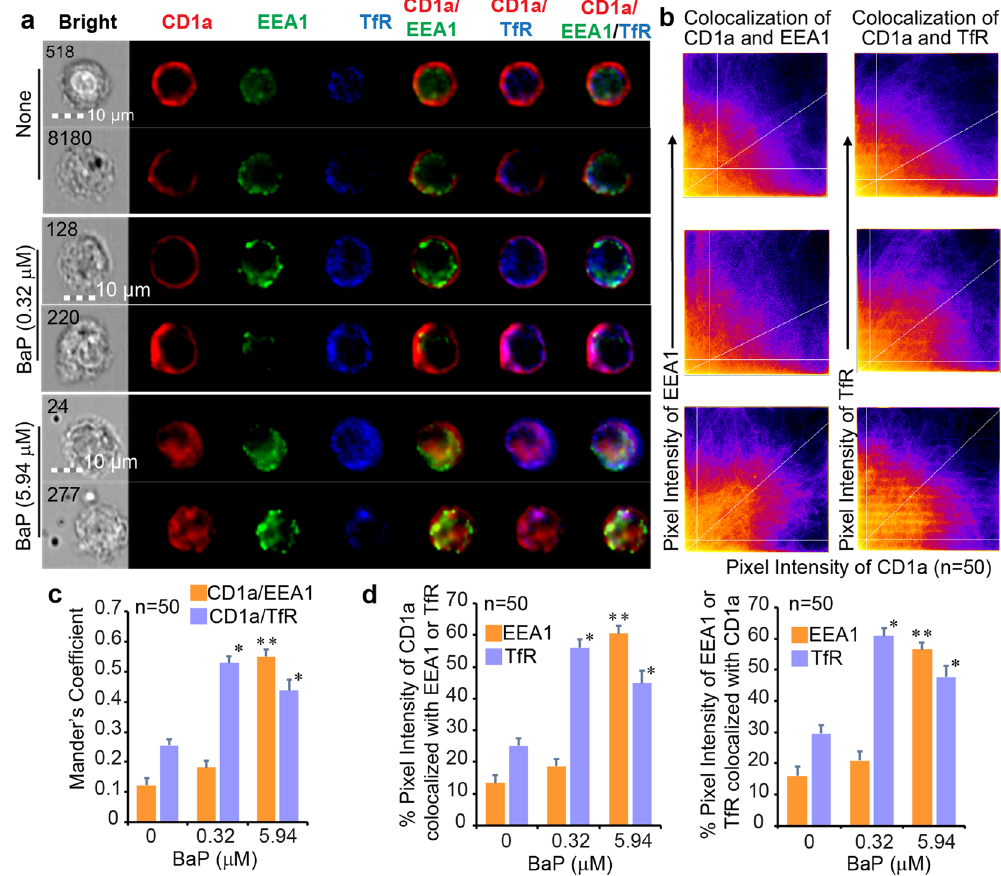
Figure 5. The CD1a protein retained in early and recycling endosomes. According to the gating strategy in Supplemental Fig. 5, two cellular images in the gated HLA-DR + CD11c + CD1a + EEA1 + TfR + population from each BaP-exposed condition are shown together with cell identities (numbers) and size bars ( a ). Fifty cells with strong co-stain and subcellular localization of CD1a, EEA1, and TfR proteins were extracted from the gated DC population from each of three BaP exposure conditions (none, 0.32 μ M, and 5.94 μ M), as exemplified in Supplemental Fig. 5b. Each cell image was manually input into ImageJ-Fiji and analyzed for the co-localization between CD1a and EEA1 proteins or between CD1a and TfR proteins. The co-localization of pixel intensity between different channels is first visualized with scatterplots ( b ), in which the horizontal and vertical lines represent Costes’s thresholds and the diagonal lines represent the ratio of overall pixel intensity between two channels. Moreover, co-localized areas were quantified with the Mander’s coefficient between CD1a and EEA1 proteins, and between CD1a and TfR proteins. Each column represents an averaged calculation of 50 cell images extracted from each of three BaP exposure conditions for one pair of co-localized proteins ( c ). Finally, the percentage of co-localized pixel intensity is also calculated. Similarly, each column represents an averaged calculation of multiple cell images (n = 50) from each BaP exposure condition for the annotated pair of co- localized proteins ( d ). Statistical significance (n = 50, p < 0.001) was obtained with Student’s t-tests in comparison to the non-exposed group ( * ) and lower exposure group ( ** ) with indicated standard errors. Data are from one experiment using cells from an independent donor. Two experiments were performed with similar